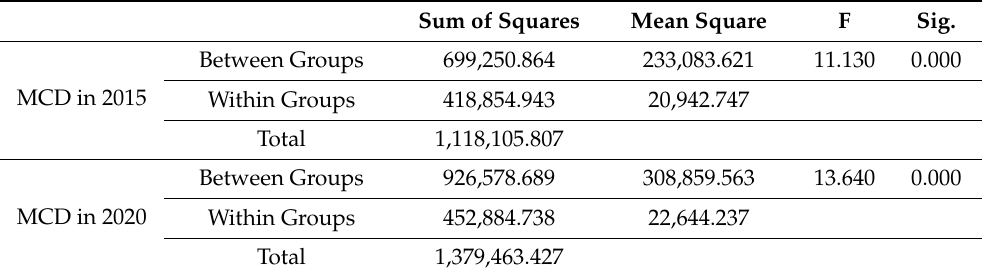
Figure 10. Differences in main landscape metrics (PA, PP, PPAR, GA) among different park groups.